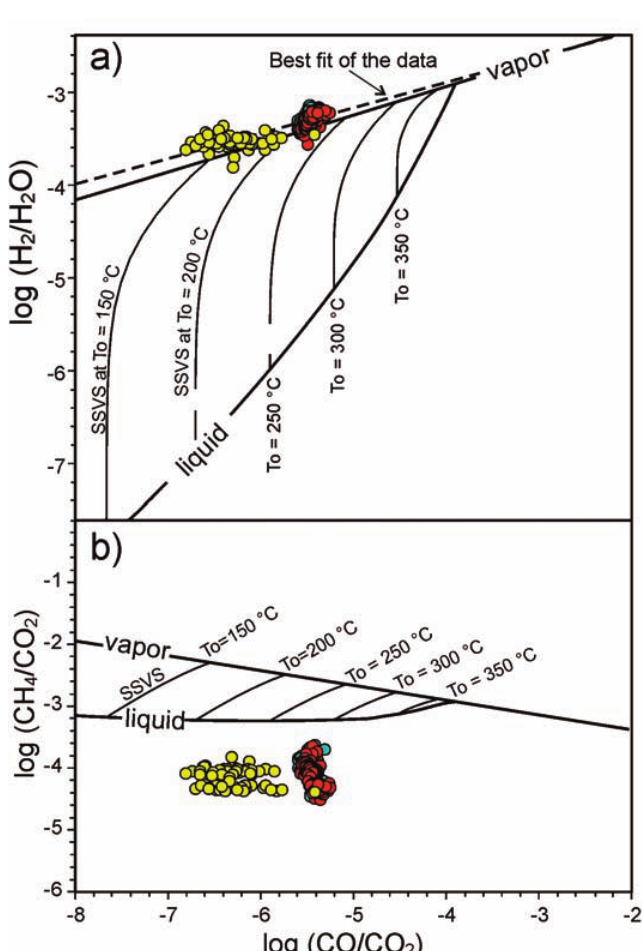
versus 1000/TK diagram. The Figure 4 (top right). Log X /X CH4 CO2 analytical ratios for the Solfatara fumaroles are plotted against the –CO isotopic equilibrium temperatures computed through the CH 4 2 geothermometer. The theoretical ratios in a single saturated vapor phase under redox conditions controlled by the hydrothermal redox buffers [Giggenbach 1987, D'Amore and Panichi 1980] are shown for reference. The theoretical ratios expected for varying water fugacities and redox -H S buffer [Giggenbach 1987] are conditions fixed by the magmatic SO 2 2 also shown. The Solfatara fumaroles fall close to the equilibrium is formed by CO conditions, which supports the concept that CH 4 2 reduction in the hydrothermal environment. /X ) versus log(X /X ). (b) Figure 5 (bottom right). (a) Plot of log(X H2 H2O CO CO2 Plot of log(X /X ) versus log(X /X ). In the diagrams, the analytical CH4 CO2 CO CO2 values are compared with the theoretical log ratios computed for the equilibrium vapor and liquid phases, and for the vapor phases separated in a single-step from the equilibrium liquids, at different temperatures. The theoretical grids assume that redox conditions are controlled by the -buffer of D'Amore and Panichi f O2